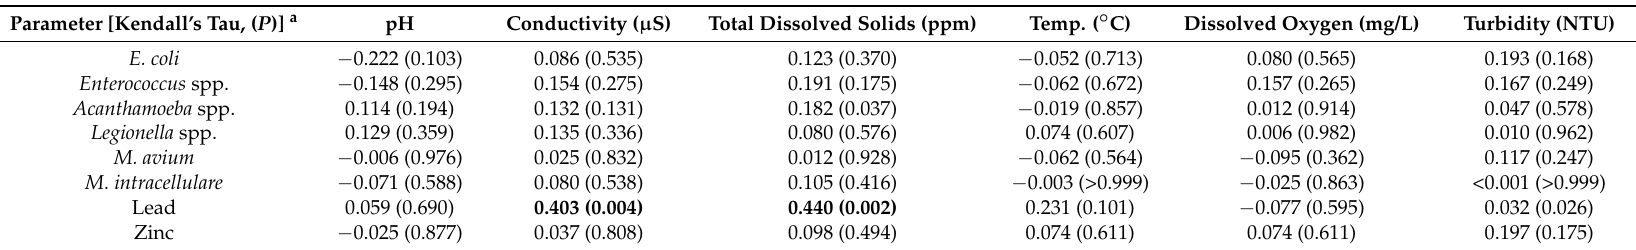
Table 4. Correlations between contaminants and physico-chemical parameters for 2016 data. Microbiological parameters with fewer than 5 positive detections were excluded. Significant values are bold-faced, with α corrected = 0.05/6 =